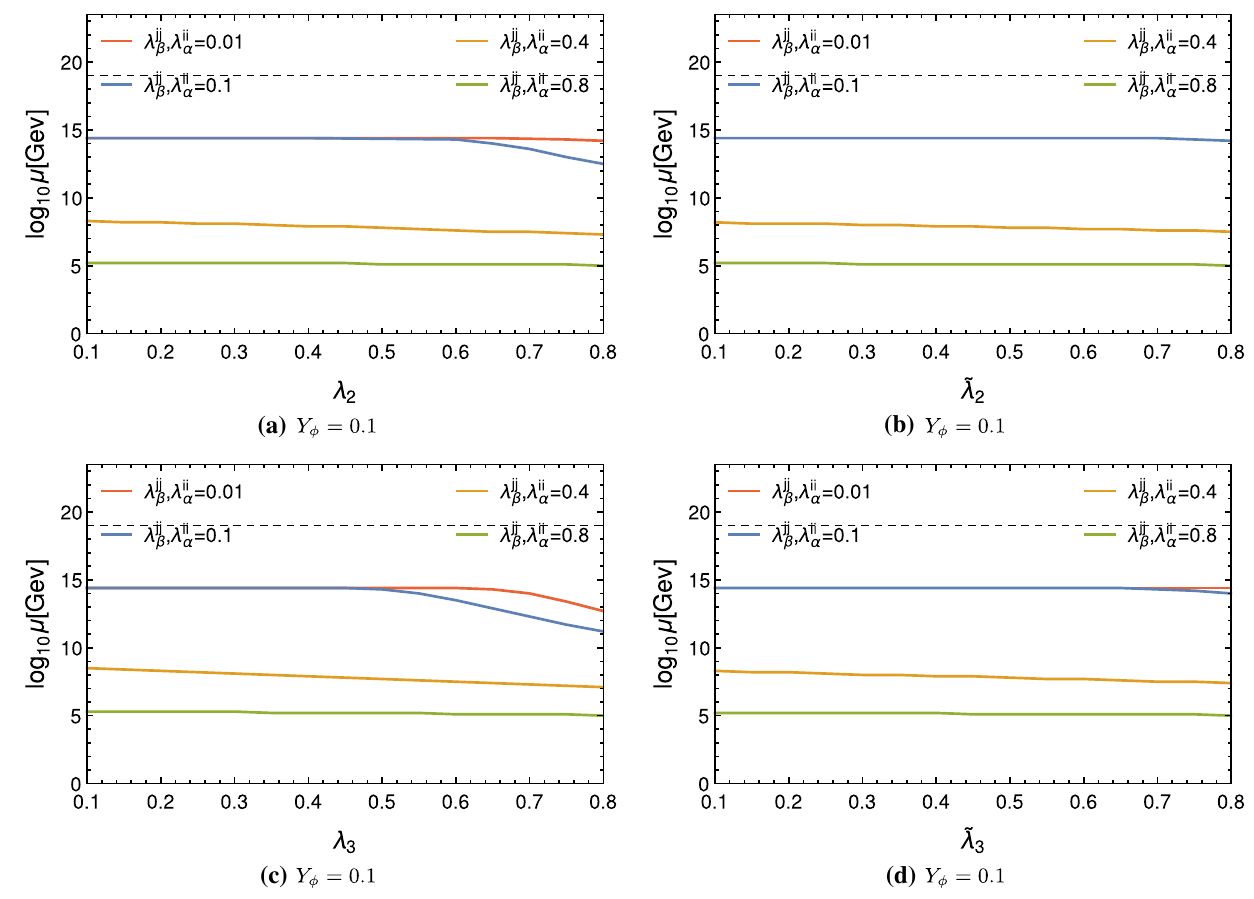
Fig. 6 Variation in quartic coupling λ 2 , (cid:2) λ 2 ,λ 3 and (cid:2) λ 3 with perturba- tive scale for three generations of (cid:2) R 2 + S 3 . Here, the variation in λ 2 is shown for any one generation of (cid:2) R 2 , and the remaining generations for the λ 2 term of R 2 are defined by λ jj β . The λ ii α term corresponds to three generations of (cid:2) R 2 for the (cid:2) λ 2 term and three generations of S 3 for the λ 3 and (cid:2) λ 3 term. Again, the (cid:2) λ 2 variation is depicted for any one generation of (cid:2) R 2 , and the remaining generations of (cid:2) R 2 are given by λ jj β for the (cid:2) λ 2